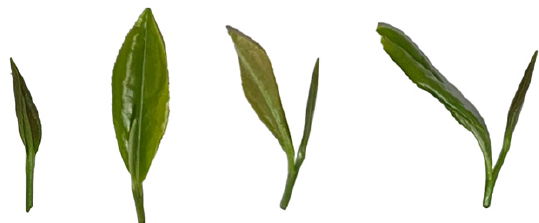
Figure 5. Measurement of the width of tea leaves.